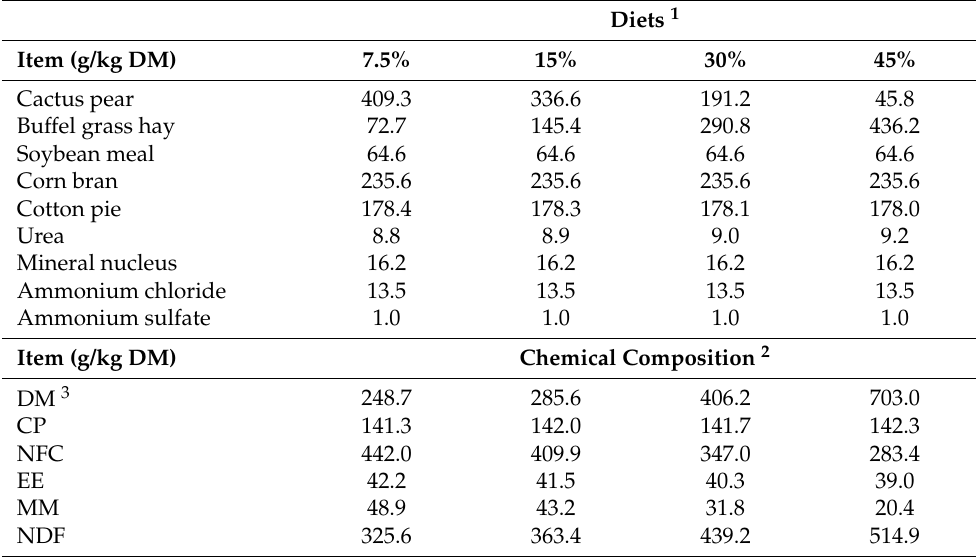
Table 2. Proportions of ingredients and chemical composition of experimental diets for sheep fed different levels of buffel grass hay, on a dry matter